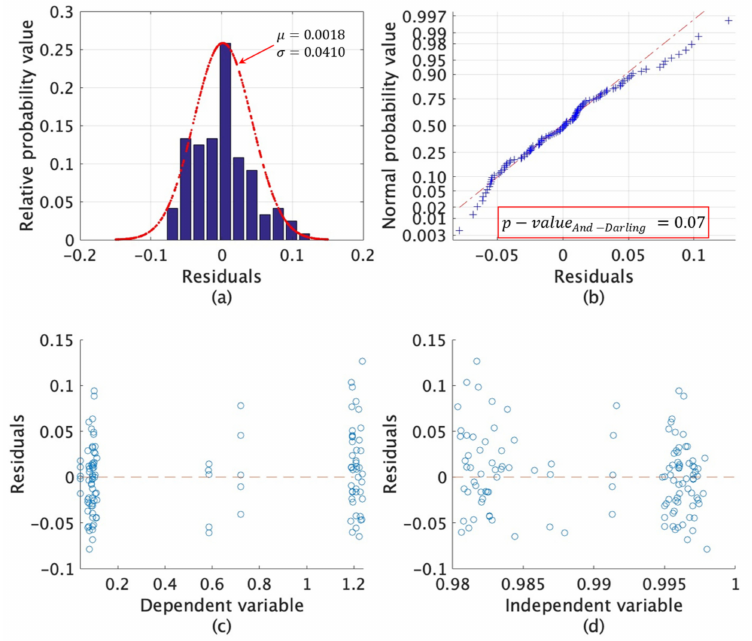
Figure 7. ( a ) Histogram of the residuals; ( b ) normal probability plot; ( c ) residuals vs. dependent variable plot; and ( d ) residuals vs independent variable plot.